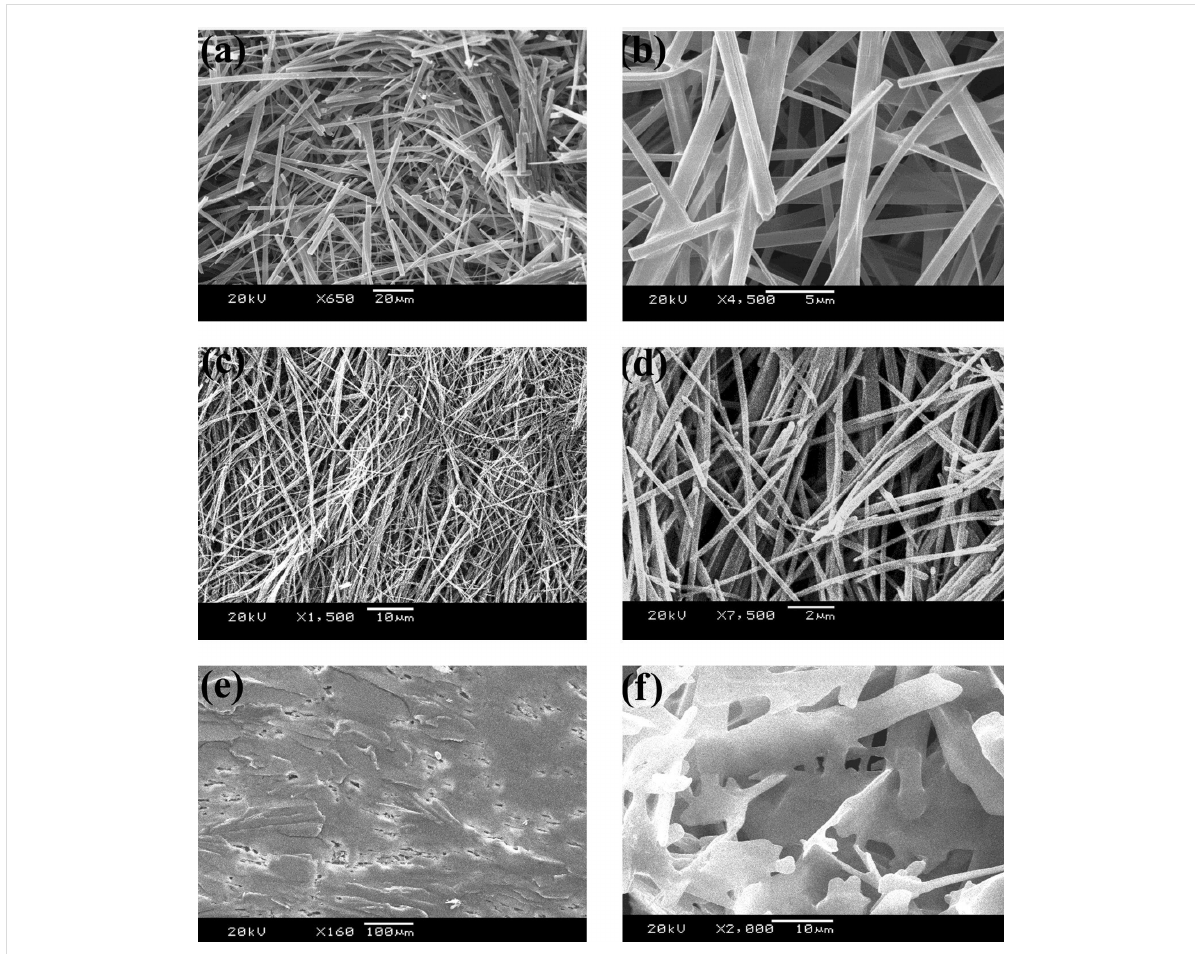
Figure 4: SEM images of the dried gels. TPM-G12 in propan-1-ol (a) and (b), in DMSO (c) and (d); TPM-G5 in DMSO (e) and (f). (a), (c), (e) are of lower magnification while (b), (d), (f) are of higher magnification.